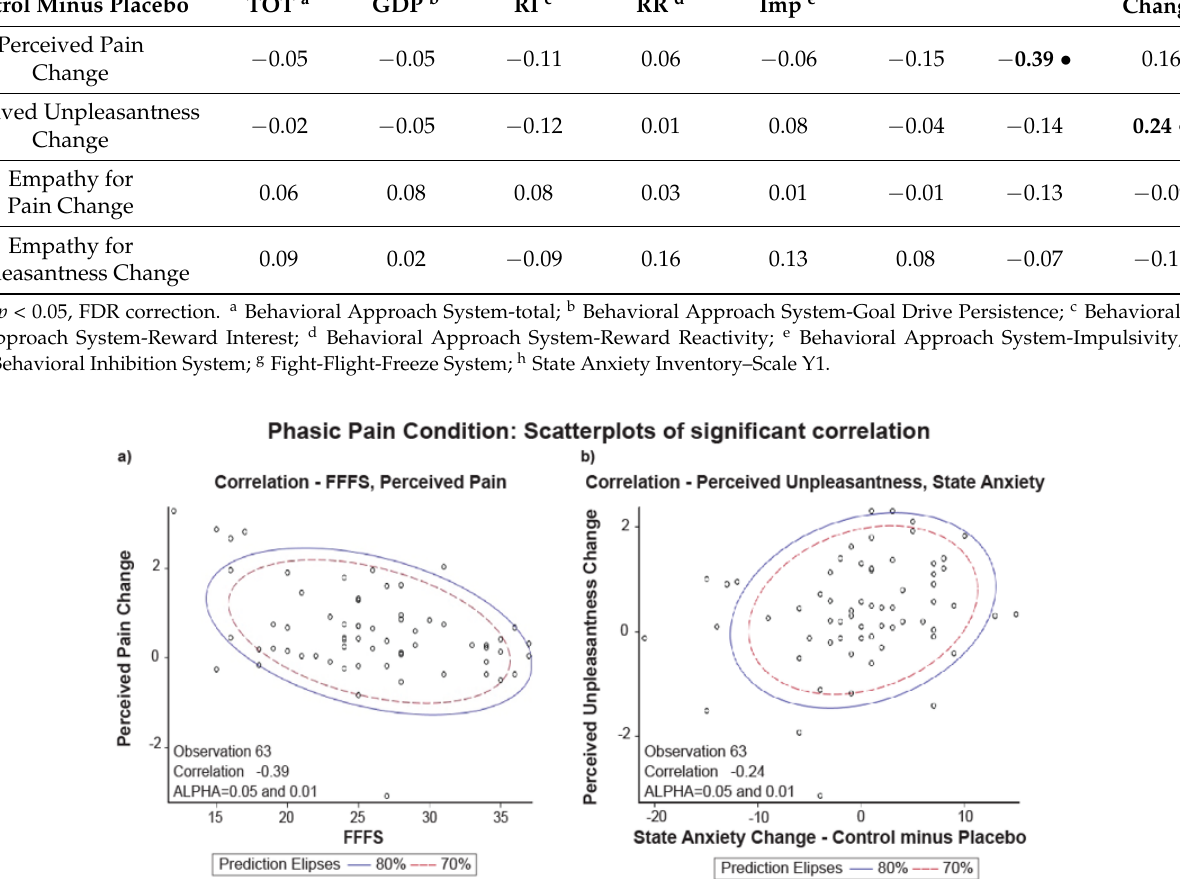
Table 1. Pearson correlations and descriptive statistics for behavioral and personality measures in 63 participants.